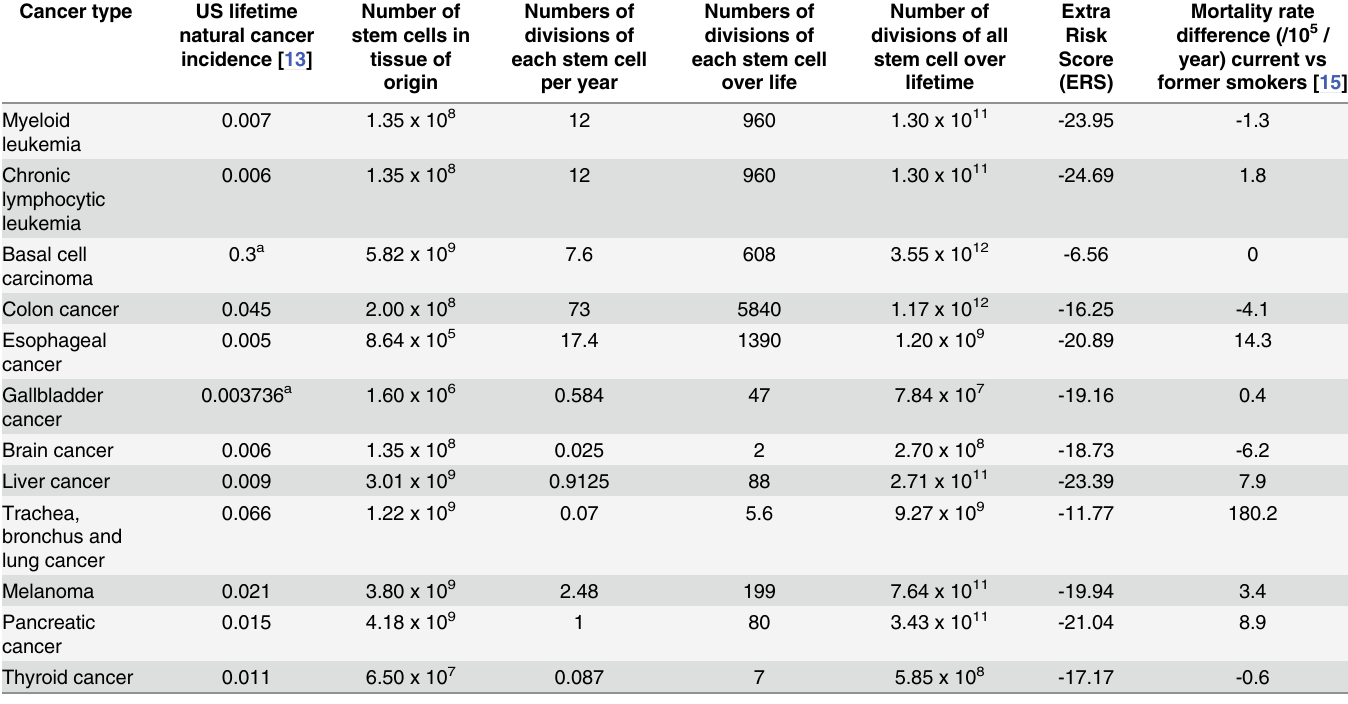
Table 2. Summary data on smoking-associated cancer risk and various tissue parameters, reproduced in part from Tomasetti & Vogelstein [2] and Doll et al . [15] Cancer type